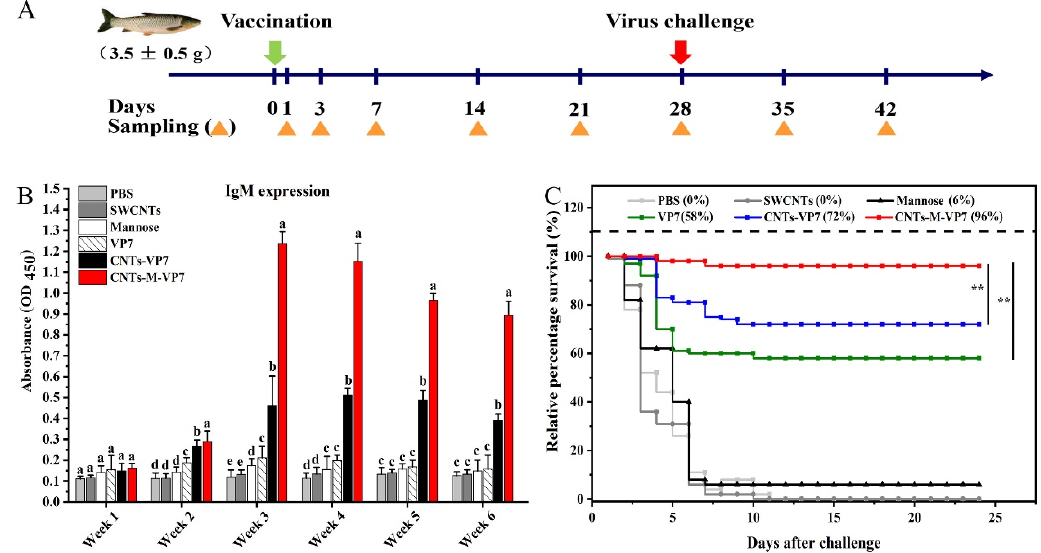
Figure 6. Immune responses in vaccinated fish. ( A ) Schematic overview of the vaccination/challenge protocol and sampling time point. ( B ) Serum specific antibody levels of fish vaccinated with different vaccines. Data are presented as mean ± SD (n = 6) and analyzed with Duncan’s test. Data at the same sampling time with different letters (a, b, c, and d) are significantly different ( p < 0.05). ( C ) Relative percentage survival after artificial challenging with GCRV in vaccinated grass carp (n = 100, per group). The survival percentage was recorded daily and calculated at the end of the monitored period. p values